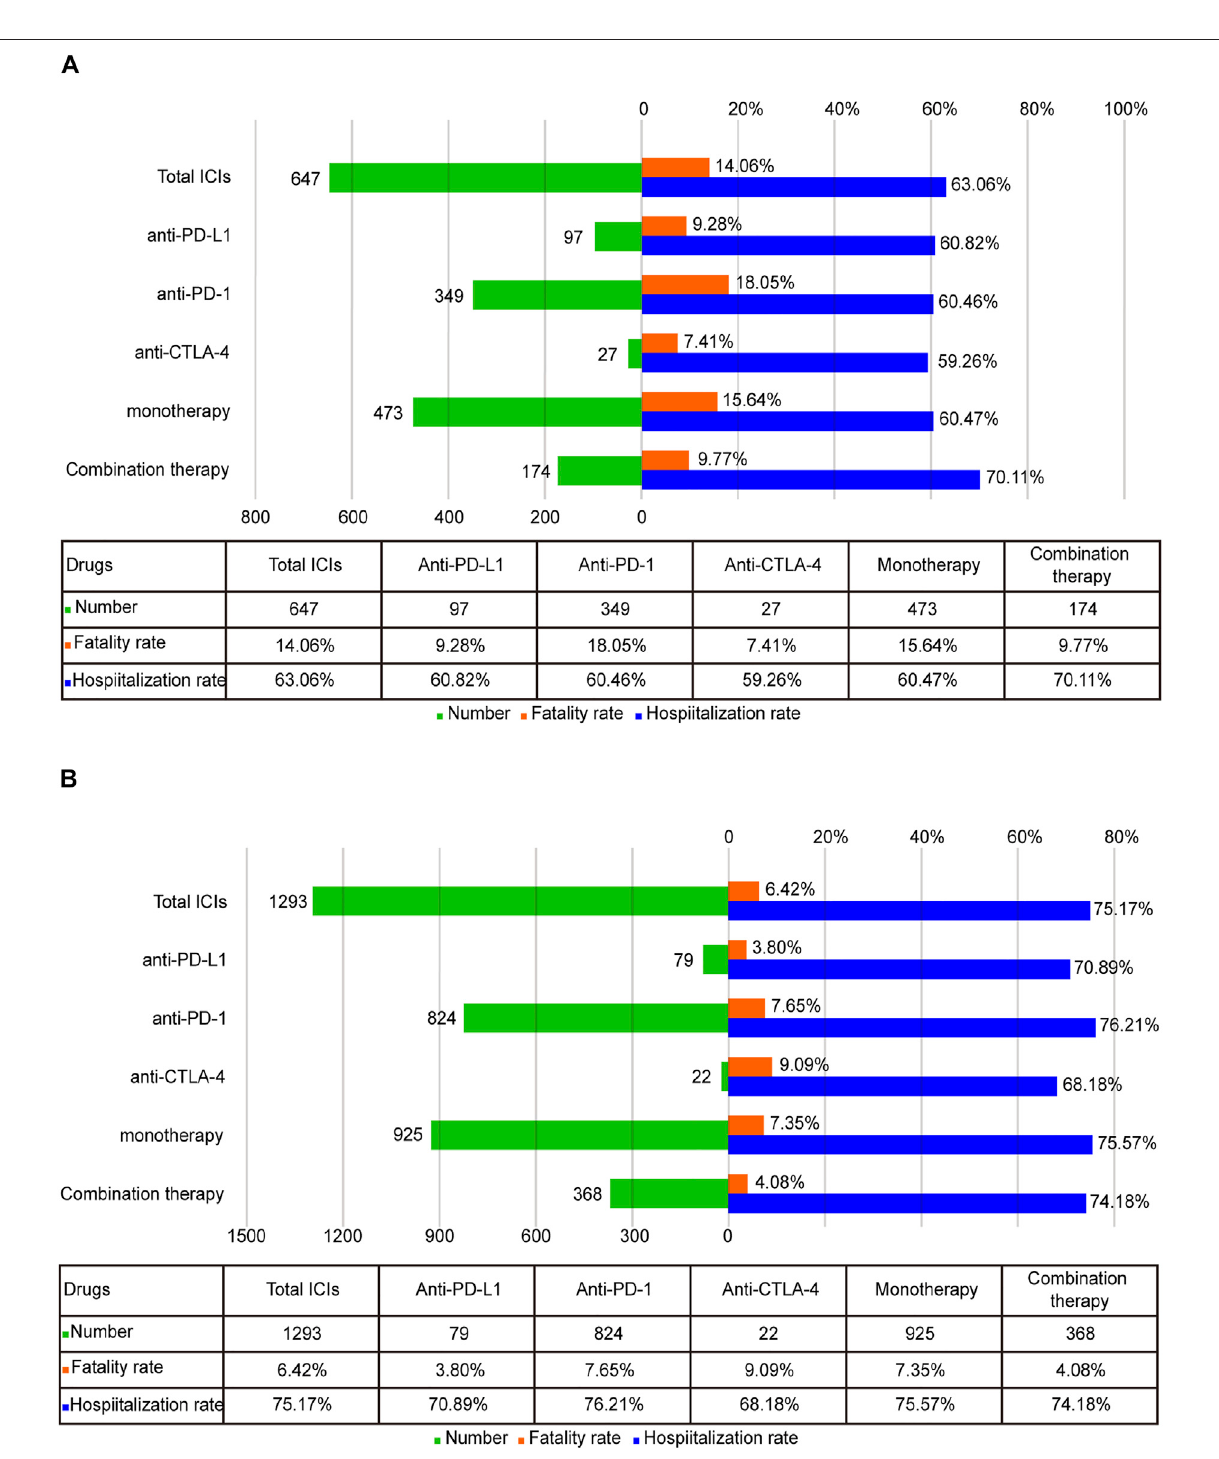
CTLA-4 (7.41%, 2 deaths of 27 cases). Nevertheless, no signi fi cant difference was found in the fatality proportion across different ICIs monotherapies ( χ 2 = 5.899, p = 0.052). Notably, the fatality